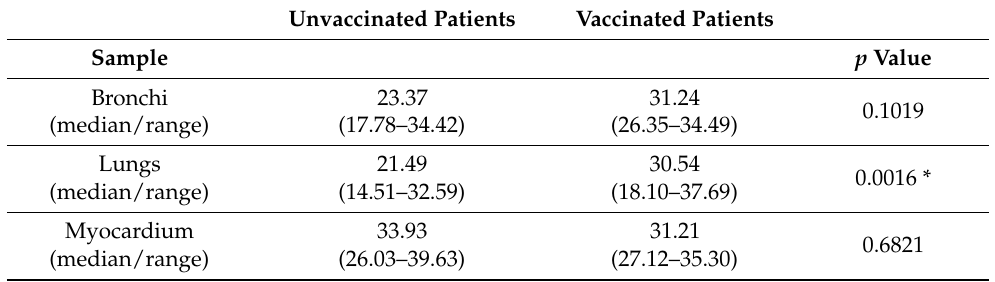
Table 3. Postmortem SARS-CoV-2 RNA detection.